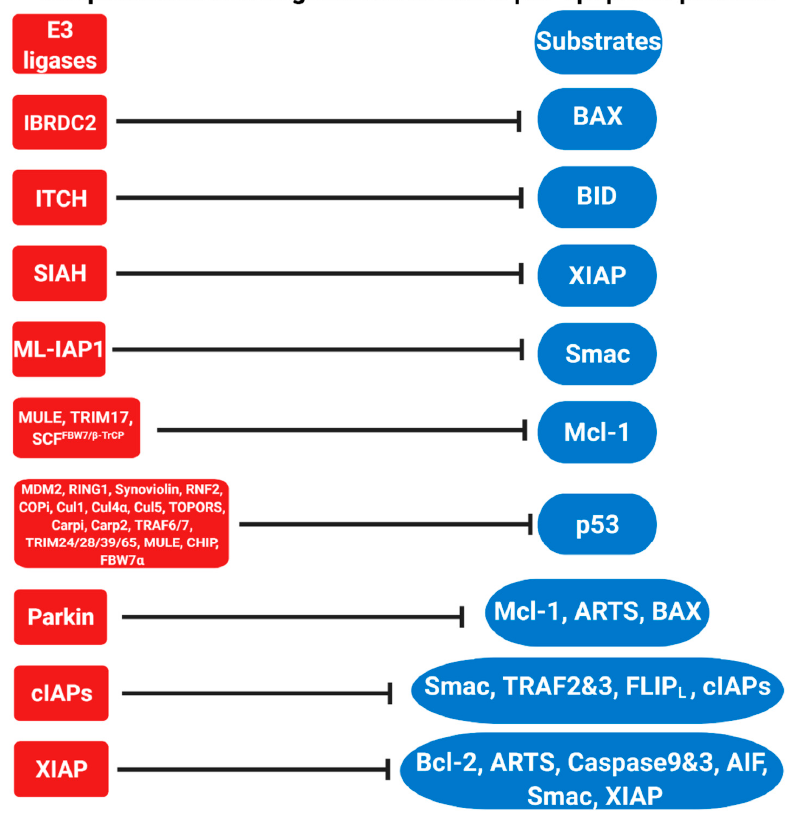
Figure 1. E3 ligases (red) regulate the apoptotic pathway by inducing the degradation of pro- and anti-apoptotic proteins (substrates in blue) via the ubiquitin proteasome system (UPS).